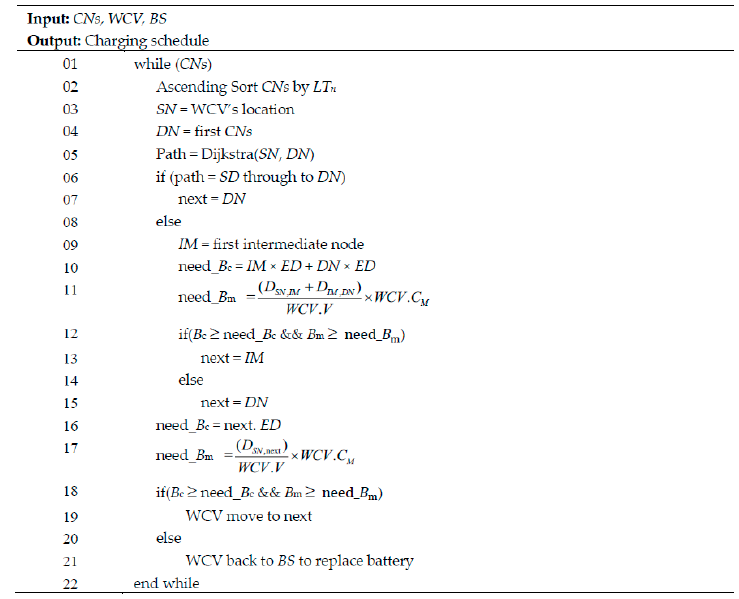
Figure 5. Best ‐ effort module algorithm. Figure 5. Best-effort module algorithm.